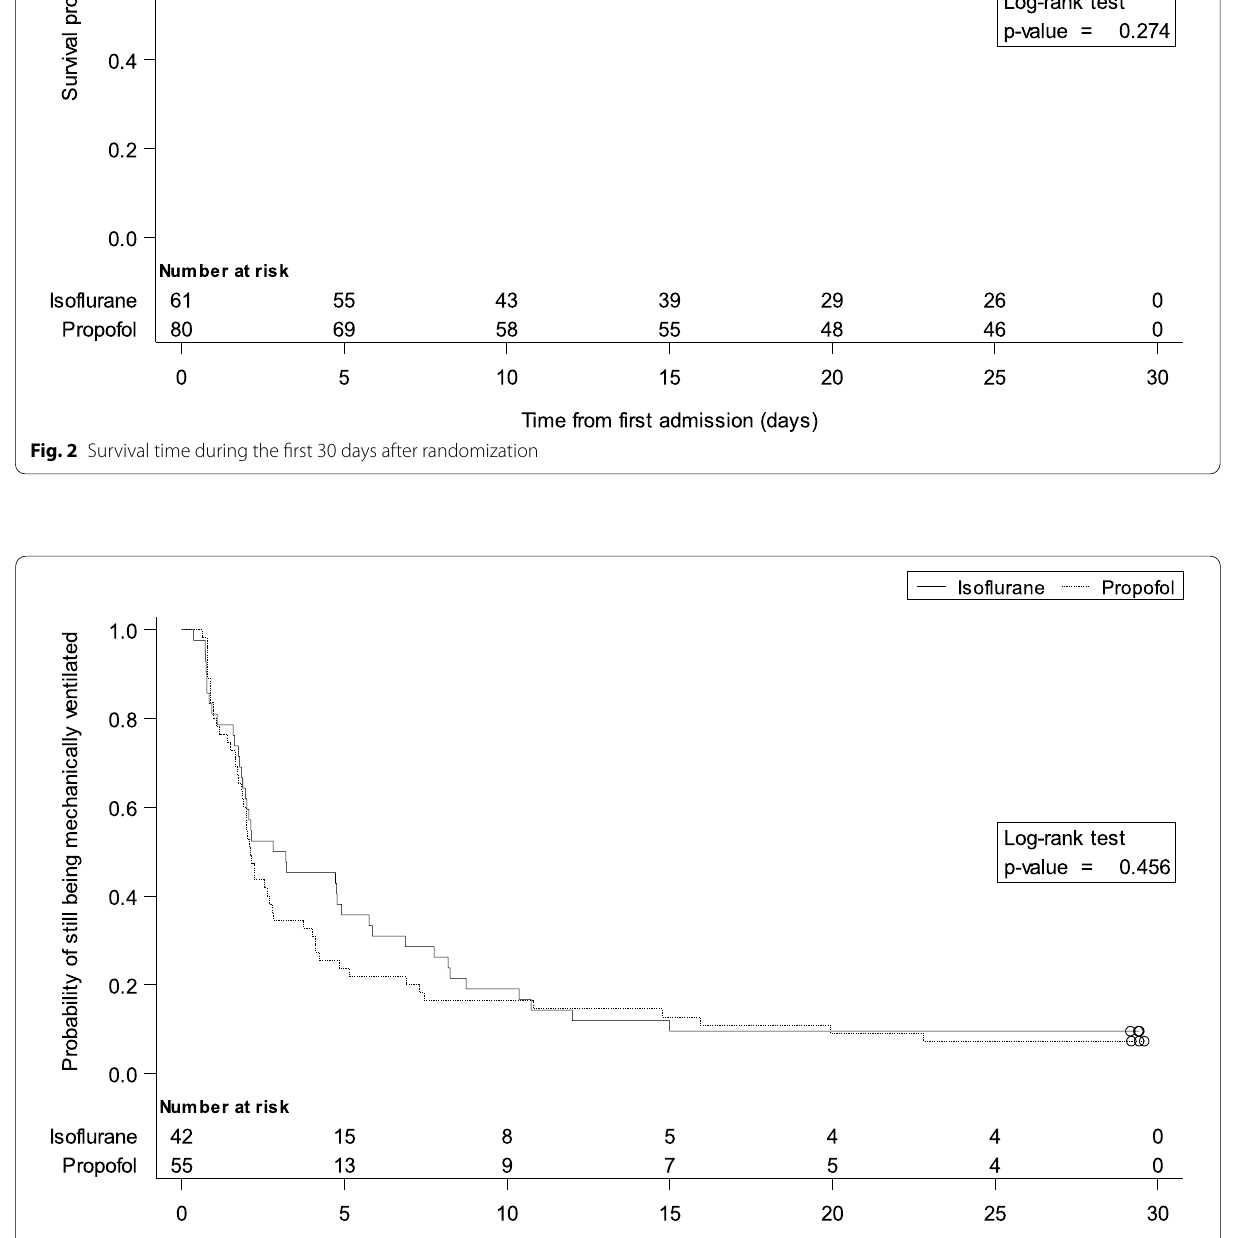
Fig. 3 Duration of first mechanical ventilation episode in the 30 days after randomization. IP